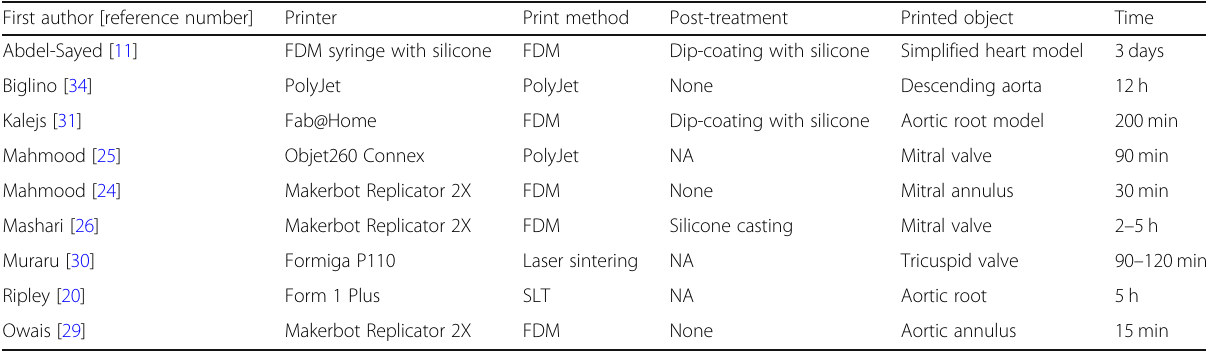
Table 2 3D printing for cardiac valve replacement: required time for different printed objects with various printing